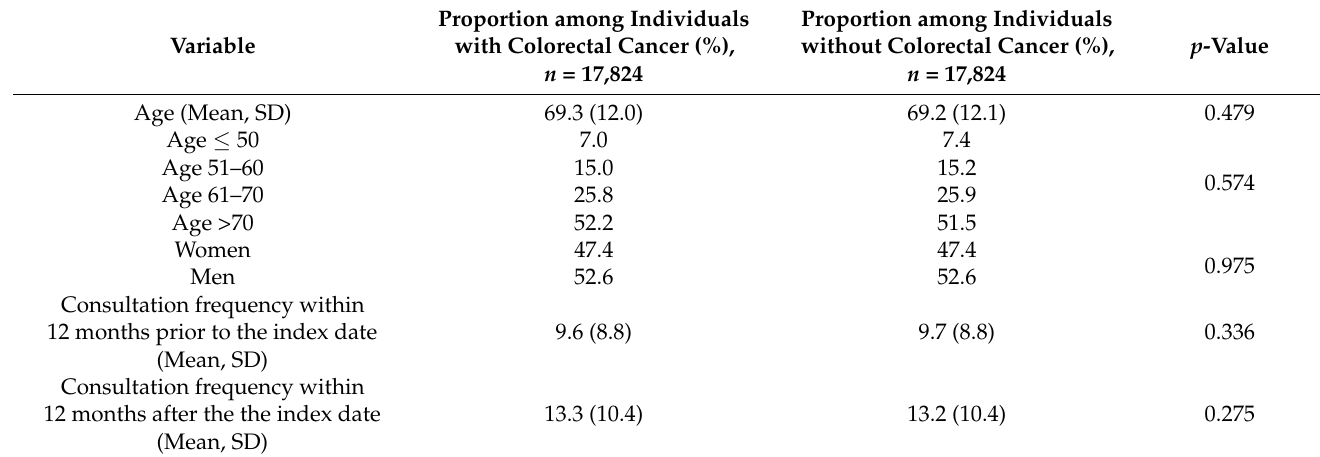
Table 1. Basic characteristics of the study sample (after 1:1 propensity score matching).